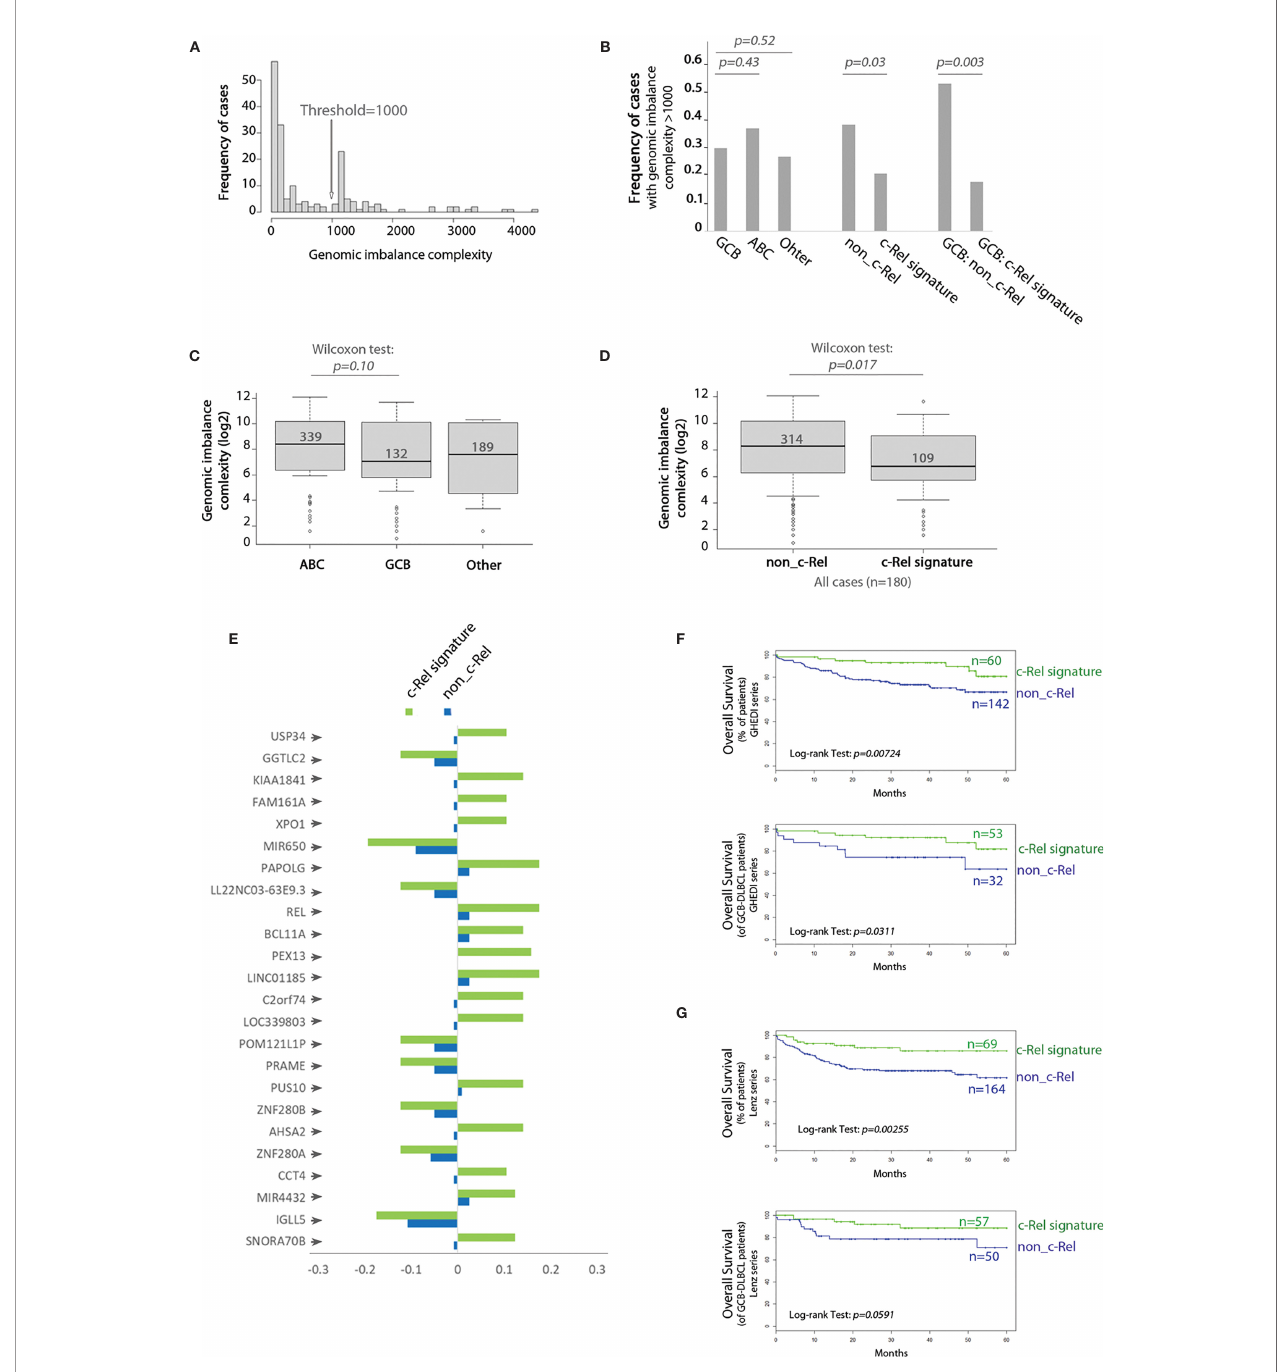
FIGURE 6 | c-Rel related gene copy number aberrations and overall survival. (A) Frequency histogram of the genomic imbalance burden reveals a bimodal distribution with a threshold at 1,000. (B) Frequency of DBCL cases with a genomic imbalance burden >1,000 according to the COO classi fi cation (left), absence (non_c-Rel) or presence (c-Rel signature) of the c-Rel signature (middle and right) among the entire GHEDI series (left and middle) or GCB-DLBCLs only (right). Chi 2 test p-values are indicated on the top. (C) Boxplot of the genomic imbalance burden according to the COO classi fi cation. (D) Boxplot of the genomic imbalance burden according to the absence (non-c-Rel) or presence (c-Rel signature) of the c-Rel signature. (C, D) Median number of gene imbalances is indicated by the black solid line. Wilcoxon test p-values are shown on the top. (E) Frequency of cases with gene copy number aberrations for the 24 gene loci speci fi cally imbalanced in DLBCL cases with the c-Rel signature. Negative values mean deletion while positive values mean ampli fi cation. (F, G) Kaplan – Meier overall survival curves of all (upper panel) or GCB (lower panel) patients from GHEDI and Lenz series respectively according to expression of the c-Rel signature (c-Rel signature, green curve) or not (non-c-Rel, blue curve). Number of cases is indicated on the right. The log-rank p-value is given within each